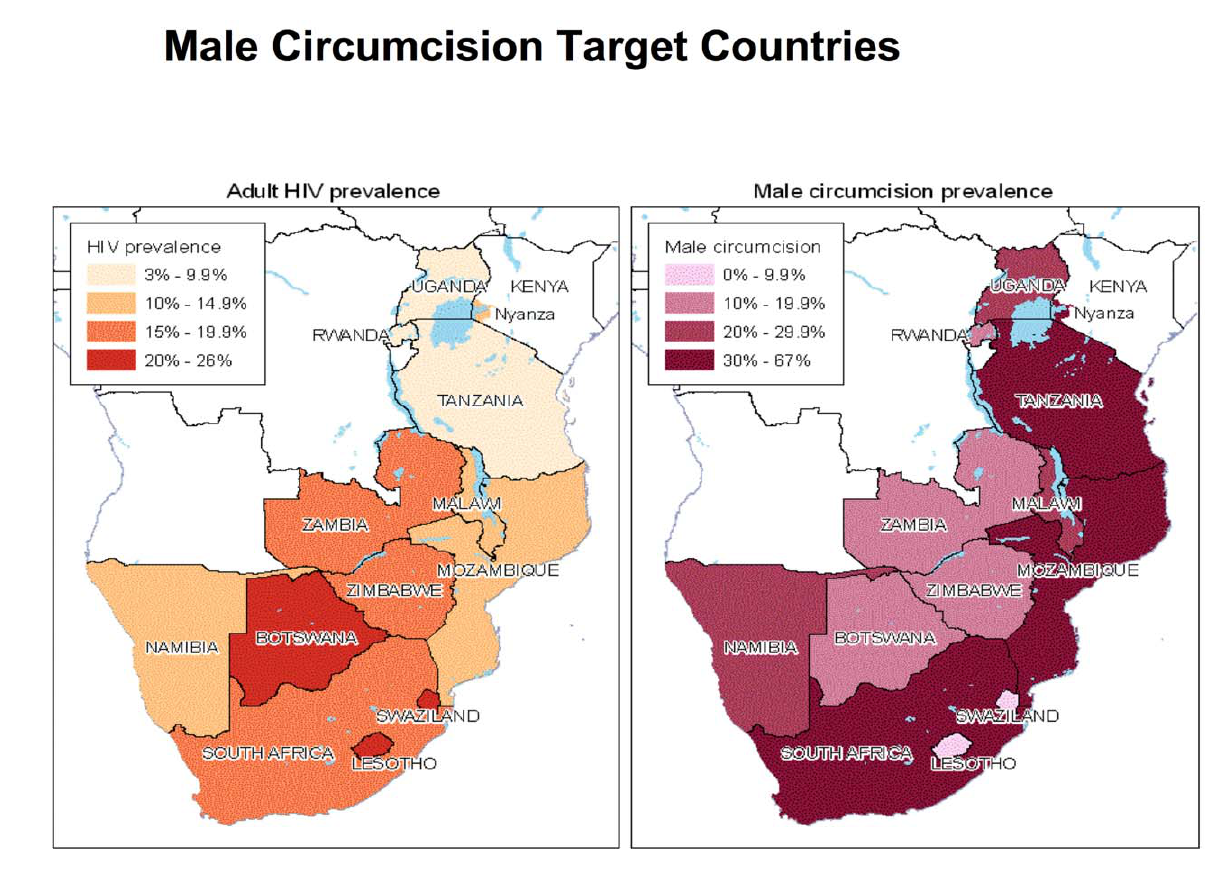
Figure 1. Geographic distribution of HIV and male circumcision prevalence. For the 13 countries included in the study, the map on the left indicates the prevalence of HIV in adults ages 15 to 49 y. The map on the right indicates the percentage of men who are circumcised.